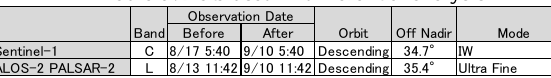
Table 5. Data used in differential analysis